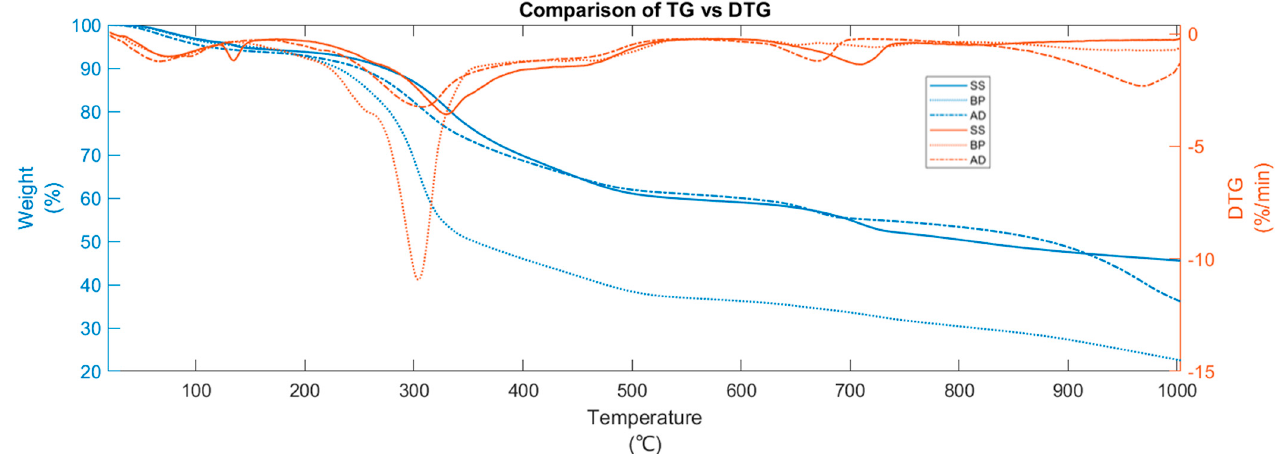
through drying, the overlapping process pathways of biomass pyrolysis are broadly clas- sified into multiple stages (Section S2.1).